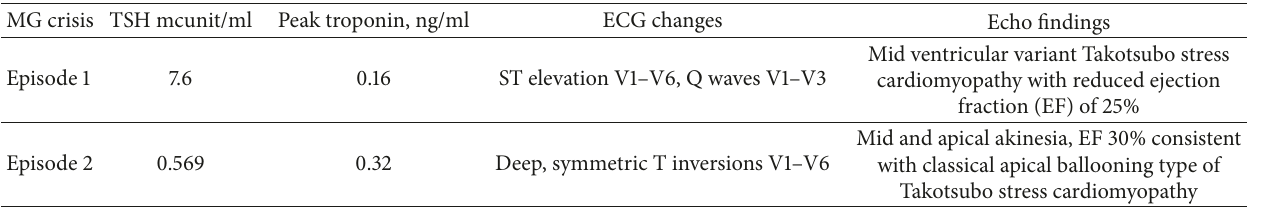
Table 1: Cardiac abnormalities and thyroid function during two episodes of myasthenia gravis crisis.